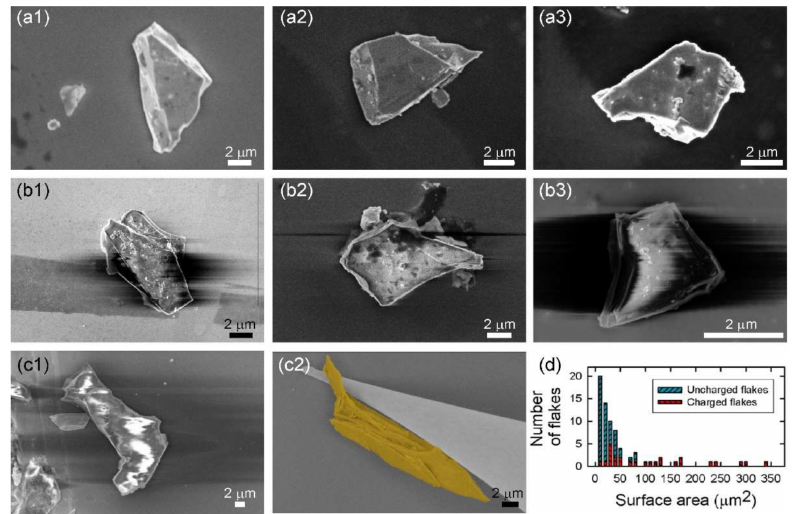
Figure 1. Scanning electron microscopy (SEM) images of typical methyl-terminated germanane microcrystallites drop-casted from an isopropanol solution on a Si surface and annealed at 180 ◦ C in ultrahigh vacuum. ( a1 – a3 ) Examples of microcrystallites which are well resolved with SEM. ( b1 – b3 ) Examples of microcrystallites which become charged under the electron beam. ( c1 , c2 ) Com- parison of the SEM image quality upon the microcrystallite manipulation with a STM tip. The crystallite is colorized to be better differentiated from the STM tip. ( d ) Statistical analysis of the occurrence of charging effects as a function of the lateral sizes of the microcrystallite basal